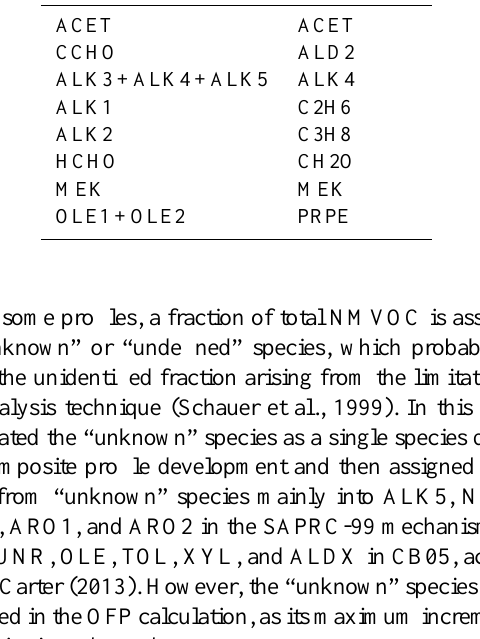
Table 2. Mapping table from SAPRC-99 species to GEOS-Chem species.